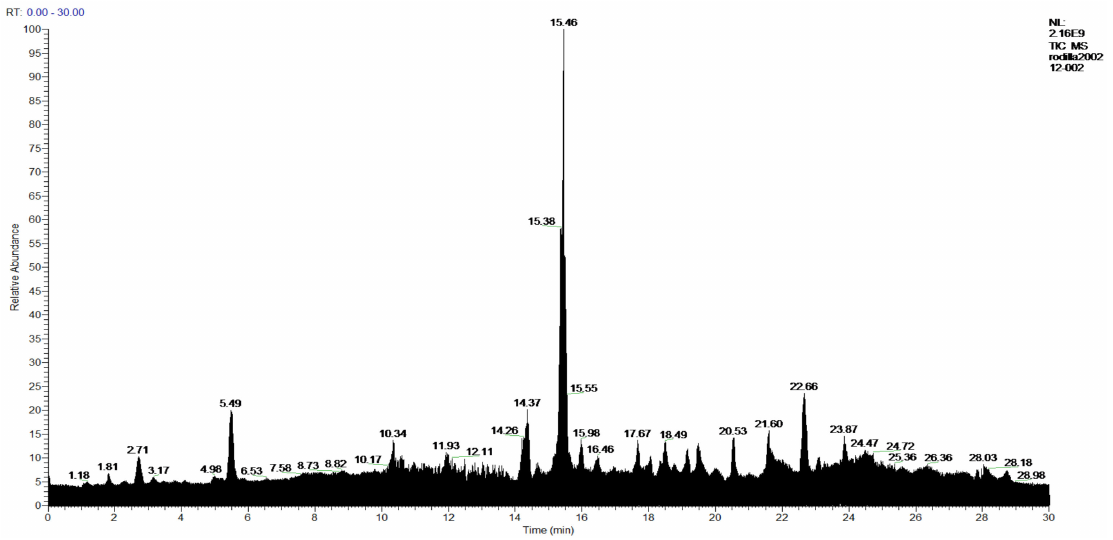
Figure 7. Chromatogram of Hexane extract part soluble in MeOH esterified whit diazomethane, 2-Hexane